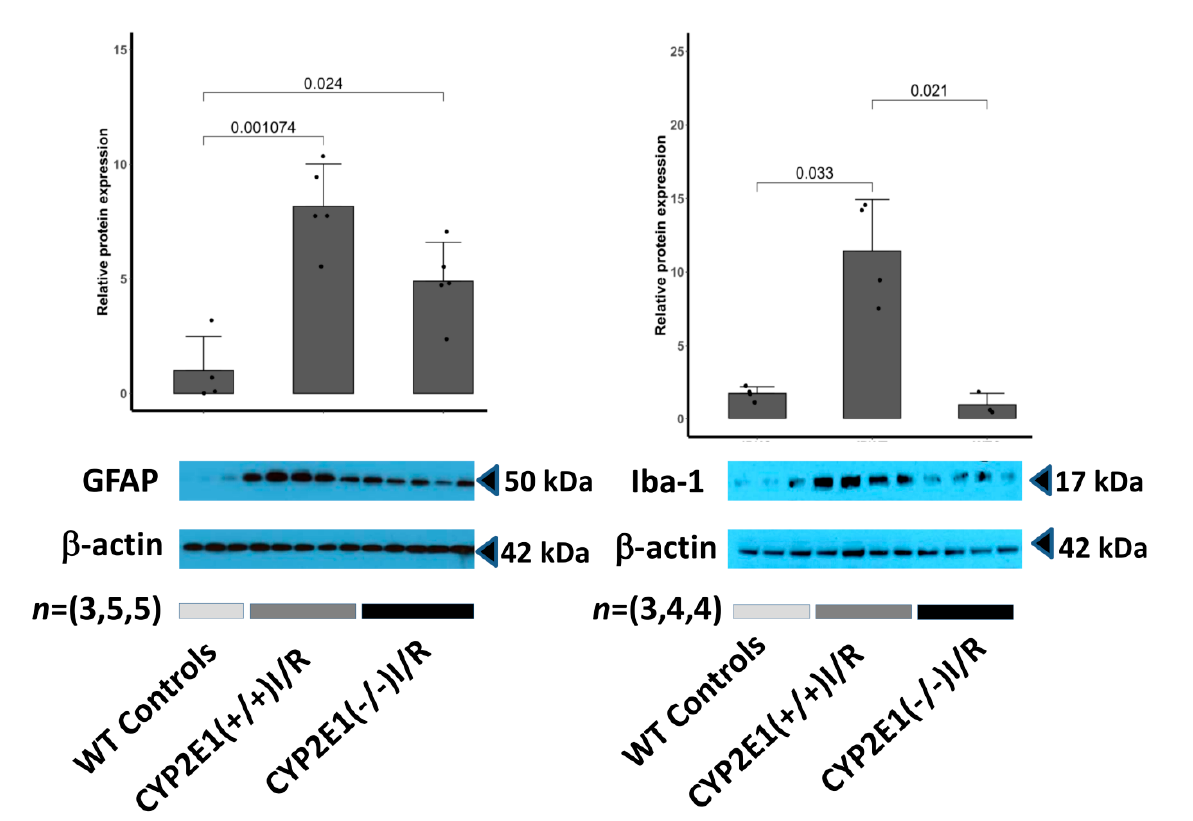
Figure 4. The quantified level of protein expression of Iba-1 ( right ) and GFAP ( left ) in the peri-infarct region of CYP2E1( − / − ), CYP2E1(+/+), and control mice brains subject to 90 min MCAo reperfusion are shown in the ( top ) of the panel. Detection of the Iba-1 and GFAP in mouse peri-infarct areas CYP2E1 and deficient in CYP2E1 (knock-out; KO), was done by Western blot analysis using rabbit polyclonal anti-Iba-1 and anti-GFAP antibody. Data are represented as mean + SD (fold change relative to mean control value), n = (3,5,5) males per group (control, CYP2E1(+/+), and CYP2E1( − / − ) for GFAP analysis and n = (3,4,4) males per group for Iba-1 analysis. A statistically significant difference between the expression of both GFAP and Iba-1 protein in CYP2E1(+/+) I/R and CYP2E1( − / − ) I/R is observed. Representative Western blots of Iba-1 and GFAP protein levels in the brain of CYP2E1( − / − ) I/R, CYP2E1(+/+) I/R, and WT control mice subject to 90 min MCAo are shown at the ( bottom ) of the panel. β -actin was used as a control for loading.